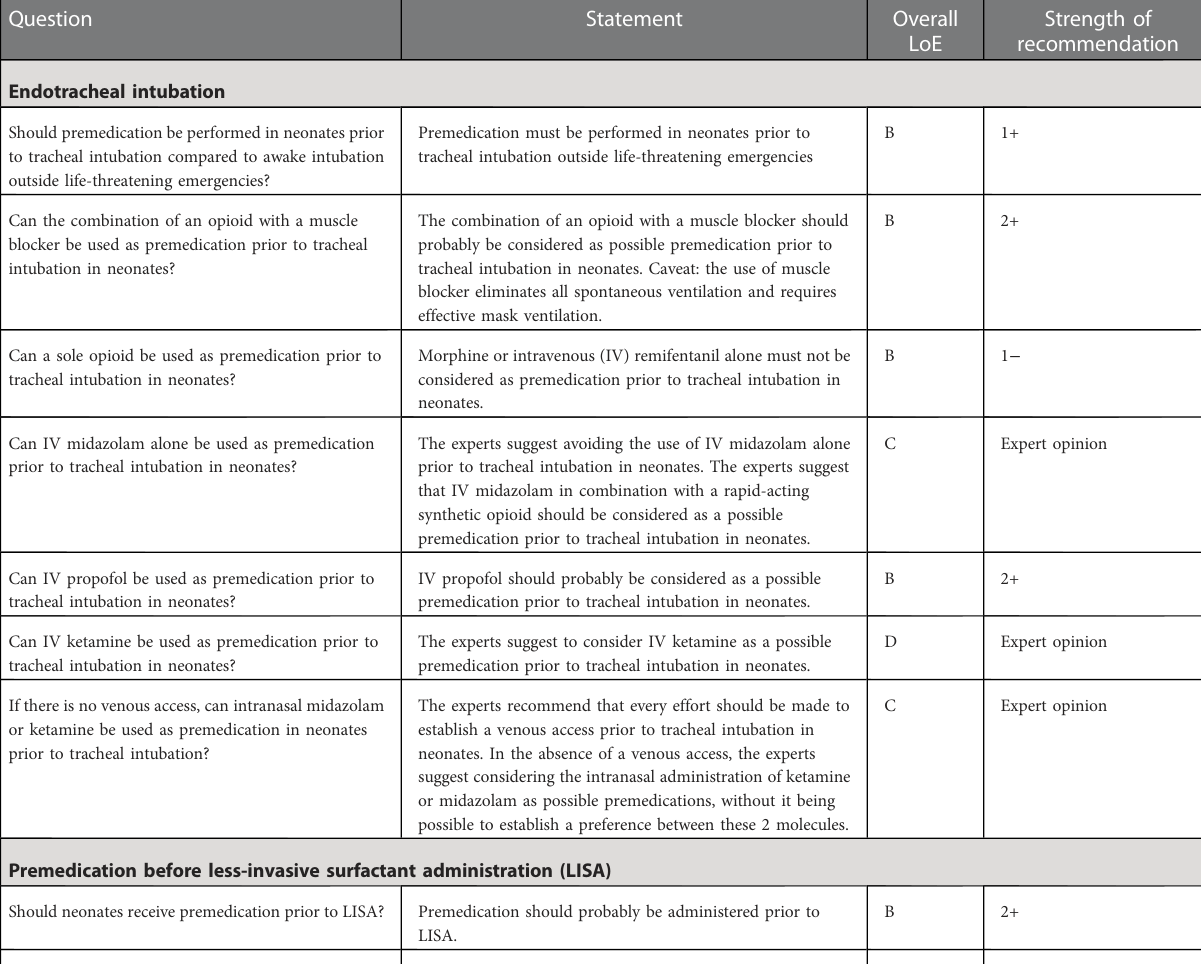
TABLE 2 Summary of good practice statements for premedication prior to neonatal laryngoscopy for tracheal intubation or LISA.